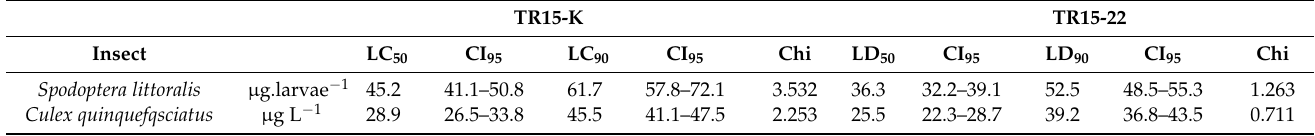
Table 3. Insecticidal activity of essential oil from tetraploid and diploid T.